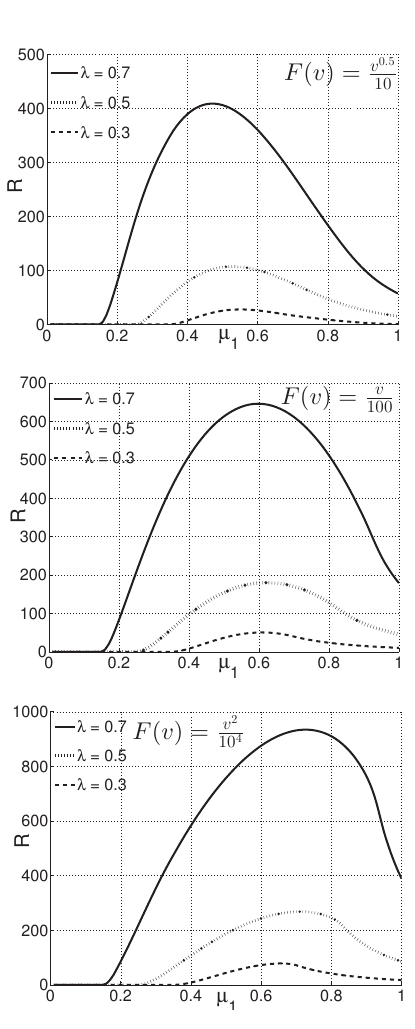
Figure 2: Revenue as a function of μ 1 for three dif- ferent example F ( v ) and different